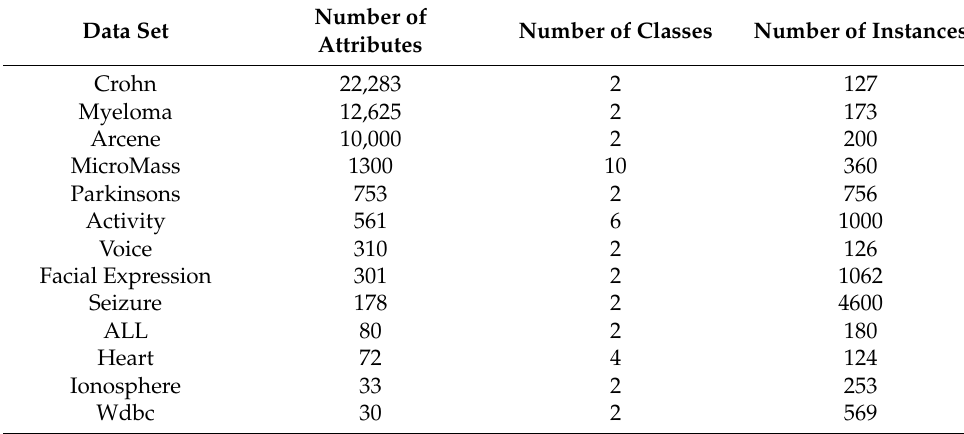
Table 2. Introduction of the thirteen data sets for